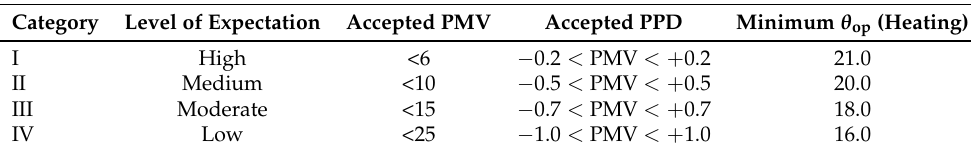
Table 1. Indoor environmental quality classes and relative index limits ( v air < 0.1 m/s; RH ≈ 50%; I cl ≈ 1